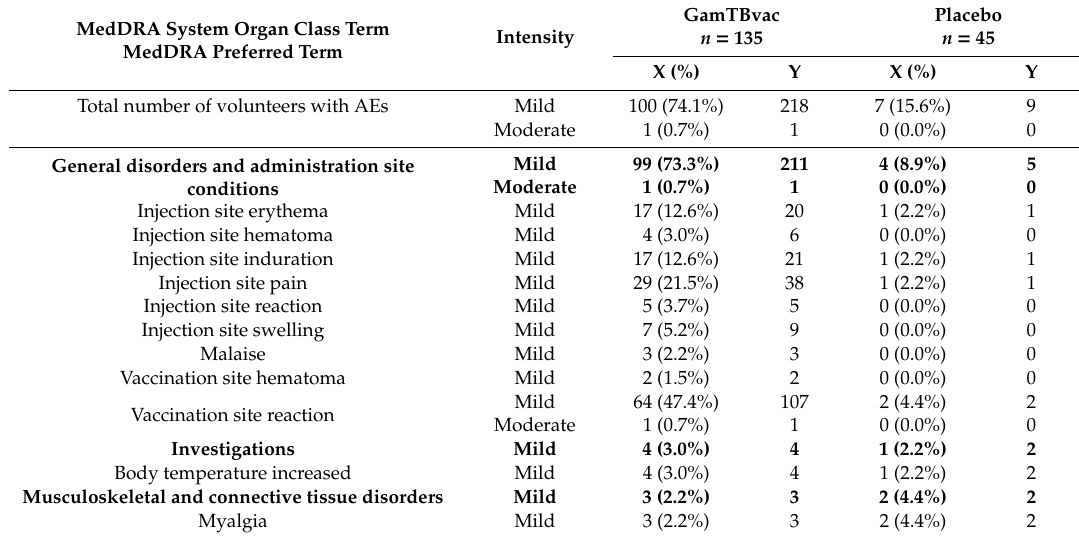
Table 1. Solicited adverse events (AEs) and their intensity, safety evaluation set, n = 180. X = Number of volunteers with at least one AE; % = Percentage of volunteers with at least one AE in the group; Y = Total number of events. MedDRA (Medical Dictionary for Regulatory Activities) System Organ Class Term is written in